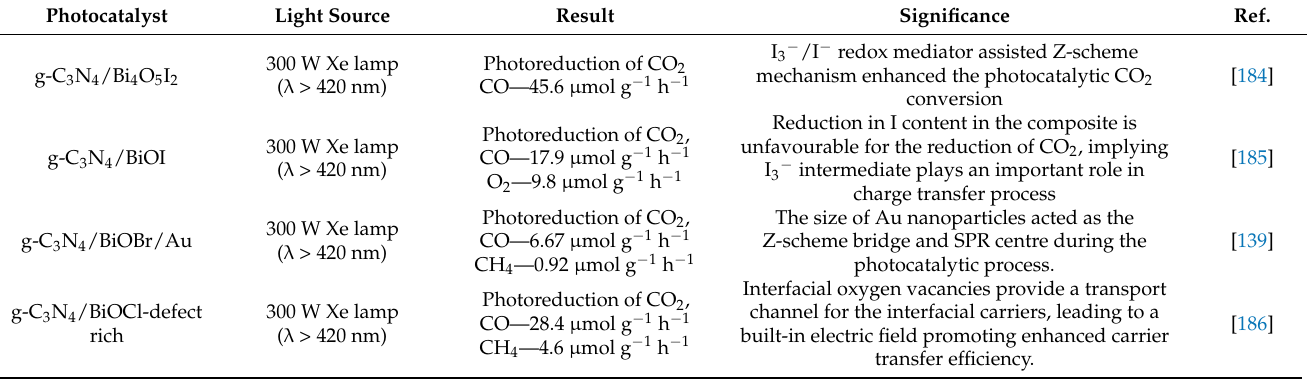
Table 2. Reduction of CO 2 in the presence of BiOX/Bi x O y X z -g-C 3 N 4 heterojunction photocatalysts reported in the literature.